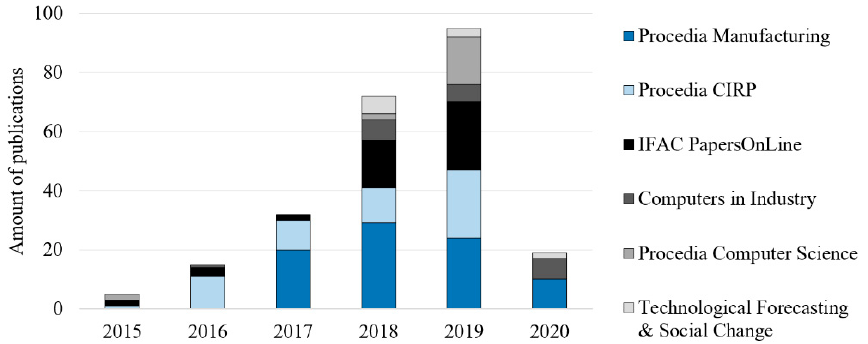
Figure 4. Distribution of publications in different journals (2015–July 2020).